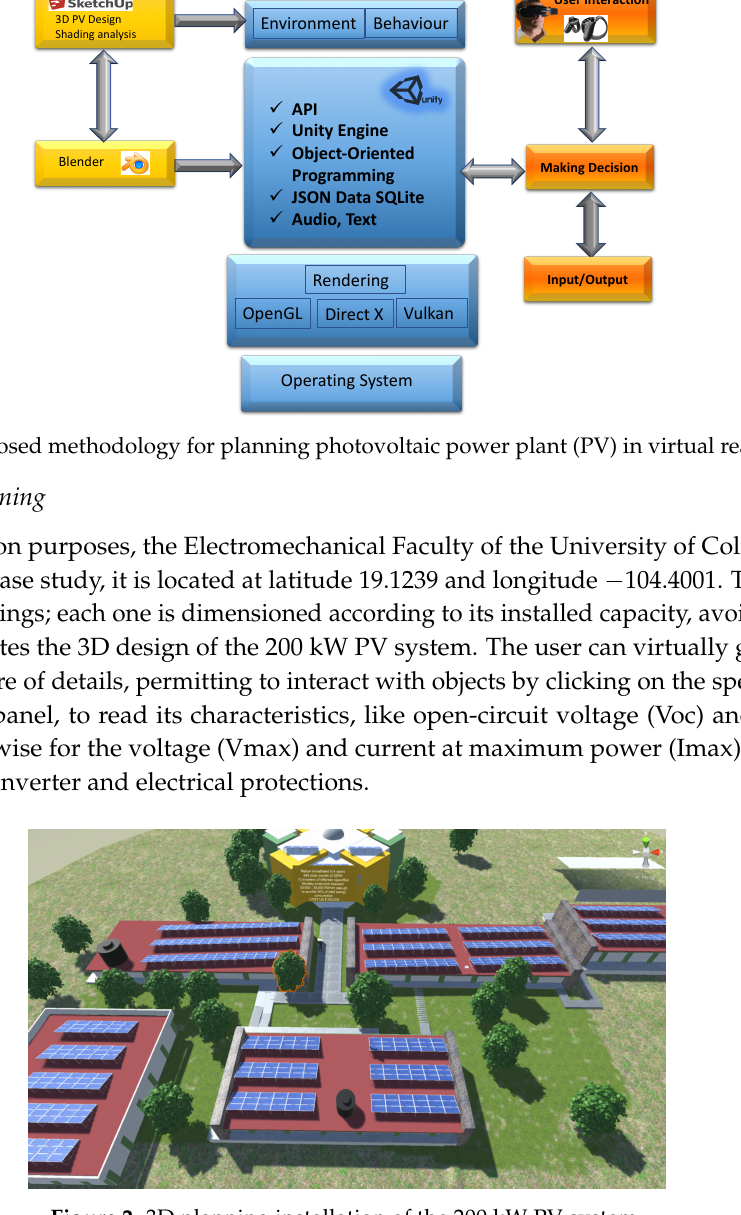
Figure 2. 3D planning installation of the 200 kW PV